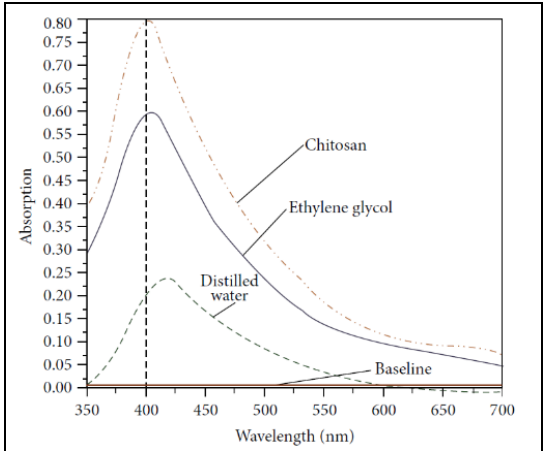
Figure 6. UV-visible absorption spectra of AgNPs prepared for 30 min ablation times in ethylene glycol, chitosan, and deionized water. Reprinted from [168], an open access article distributed under